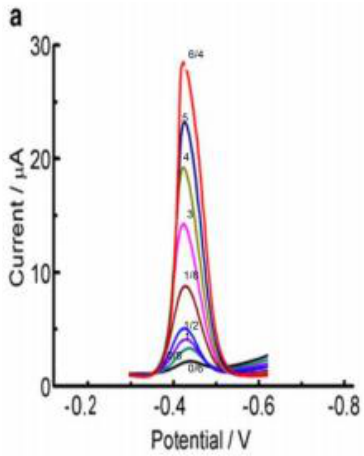
Fig.6- SWV of the modified electrode with different concentration of target DNA